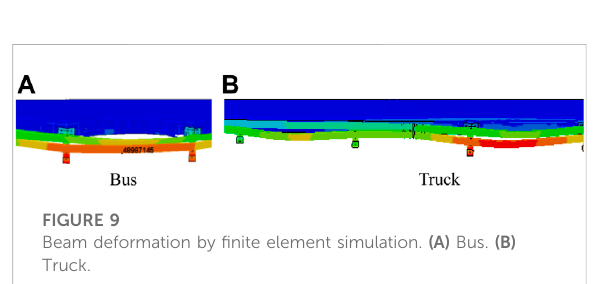
FIGURE 9 Beam deformation by fi nite element simulation. (A) Bus. (B)